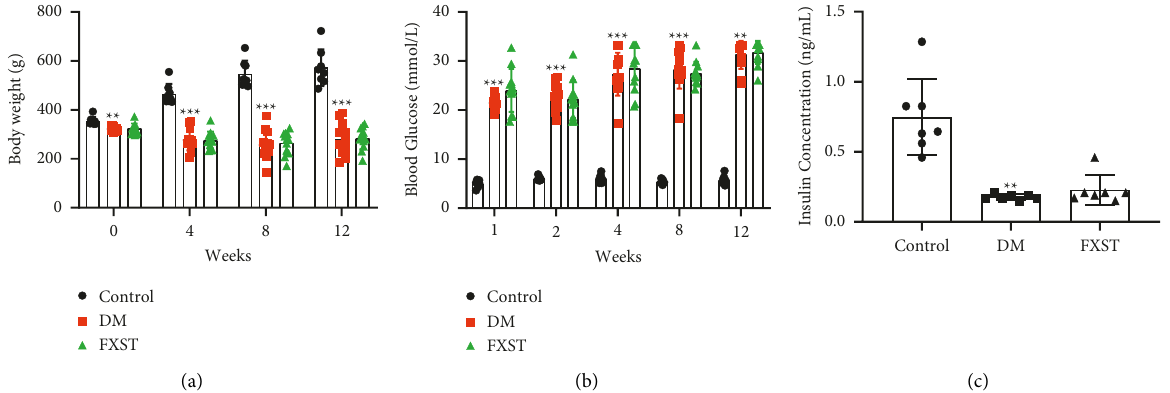
Figure 1: Effect of FXSTon general characteristics in DM rats. (a) Body weight was measured at 0, 4, 8, and 12 weeks. (b) Blood glucose was measured at 1, 2, 4, 8, and 12 weeks. (c) Insulin levels were measured at termination. Data are expressed as the mean